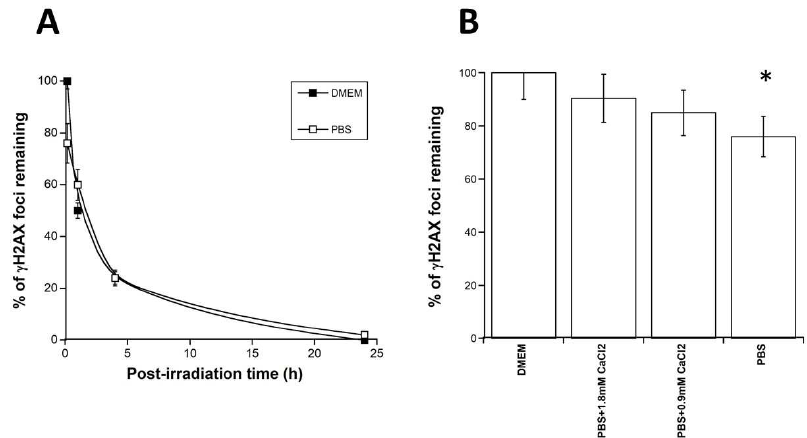
Figure 8. Influence of calcium on the DSB repair kinetics of the radioresistant 1BR3 fibroblasts . Cells were irradiated (2 Gy) with 6 MeV photons in presence of the indicated media. Each data plot rep- resents the mean – standard error of at least three replicates. ( A ) Kinetics of γH2AX foci. Data were fitted to the Bodgi’s formula [47]. ( B ) Histogram representing the γH2AX foci values (as percentage of foci remaining) assessed 10 min post-irradiation with the indicated media. Each data plot repre- sents the mean – SEM of at least three replicates. Asterisk represents p < 0.05.